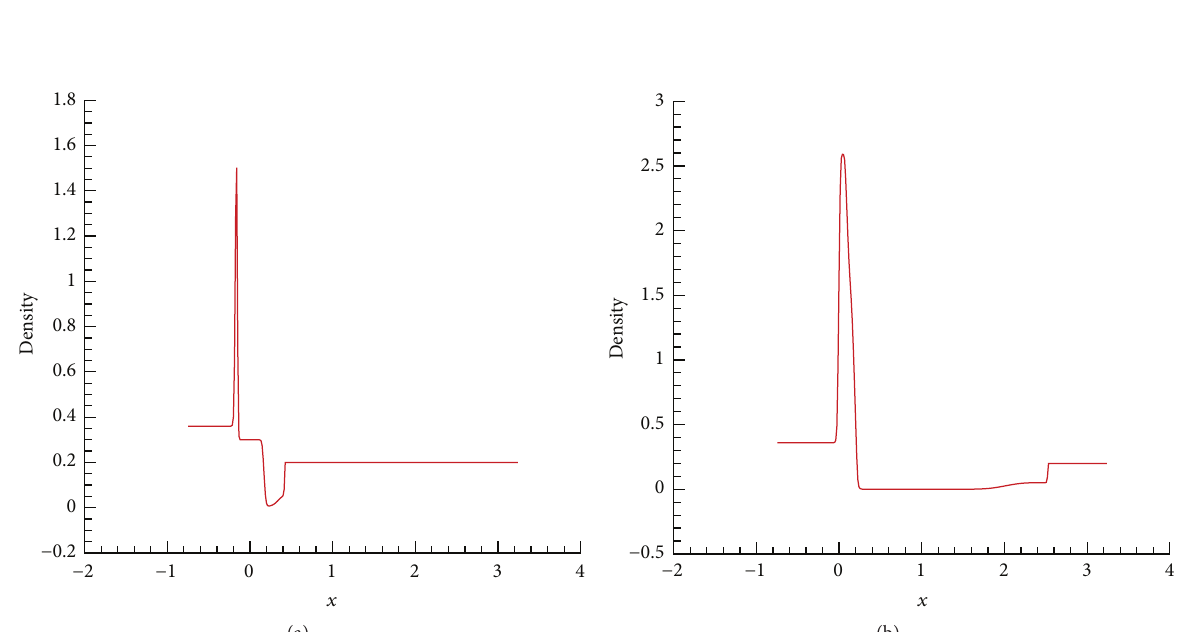
Figure 12: Numerical results of 𝜌 at 𝑡 = 0.5 (a) and 𝑡 = 5.5 (b) for Data